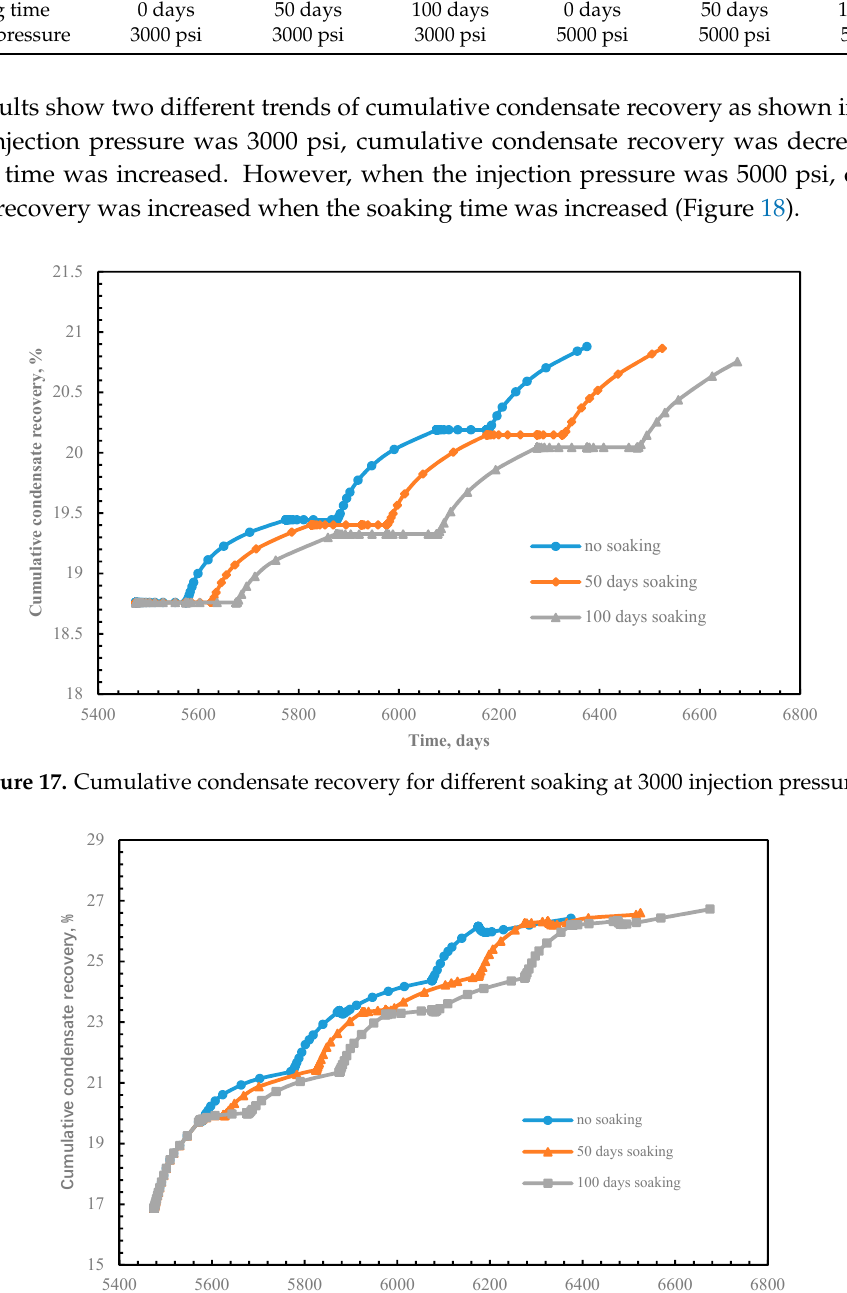
Table 4. Different scenarios used in the study of soaking period effect.